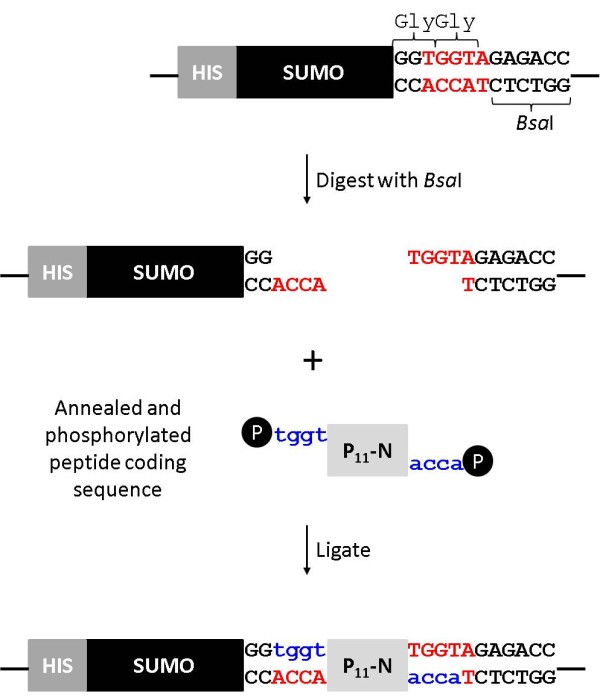
Cloning strategy outlining the cloning of peptide coding regions at the BsaI restriction site of pET28_ SUMOadapt.